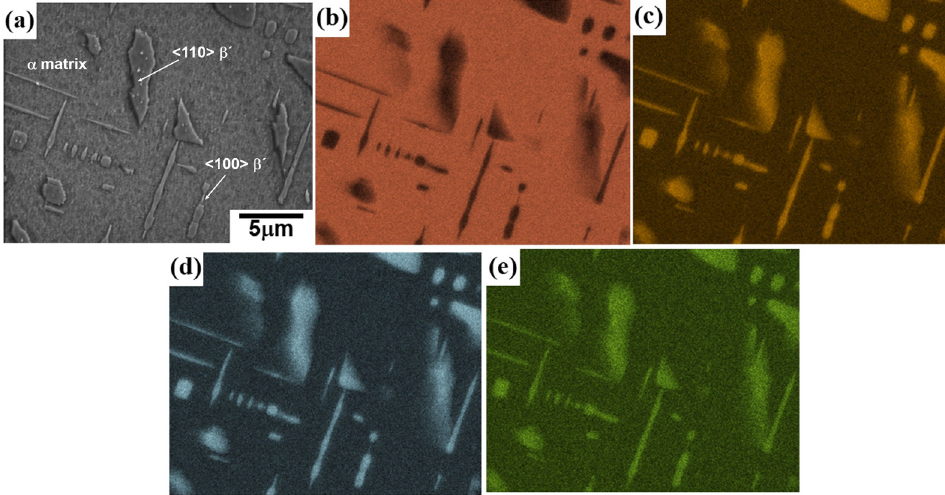
Figure 9. (a) FEG-SEM image and the corresponding EDX-SEM elemental mapping images of (b) Cr, (c) Mn, (d) Ni, and (e) Fe for the Fe-10at.%Ni-15at.%Al-5at.%Cu alloy aged at 850 °C for 100 h. Table 1. EDX-SEM analysis of β´ precipitates for the Fe-10at.%Ni-15at.%Al-5at.%Cu alloy aged at 850 °C for 100 h. Alignment at. % Fe at. % Ni